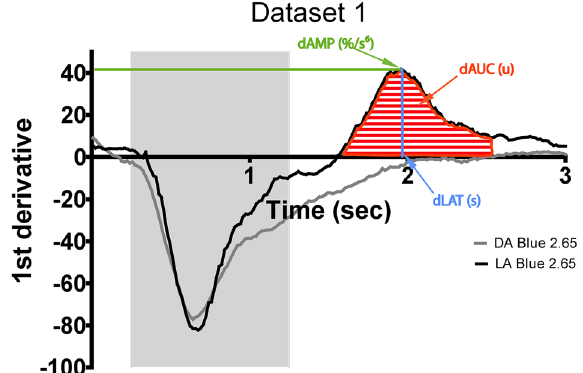
Figure 3. Schematic figure showing the parameters obtained from the derivative curve response. The mean derivative curve in dark-adapted (grey line) or light-adapted (black line) conditions in response to 2.65 log cd/ m 2 blue stimuli (dataset 1) is represented as a function of time. Note the difference in the shape of the curve such that grey line does not cross Y = 0. This difference illustrates how dAMP, dLAT and dAUC can discriminate between the two types of the early pupillary dilation kinetic. dAMP reflects the maximal positive peak amplitude and dLAT is its latency. The dAUC corresponds to the area under the curve of the positive peak of the derivative. These three parameters are shown for the derivative curve of the light-adapted response (black line). LA: light-adapted; DA: dark-adapted.